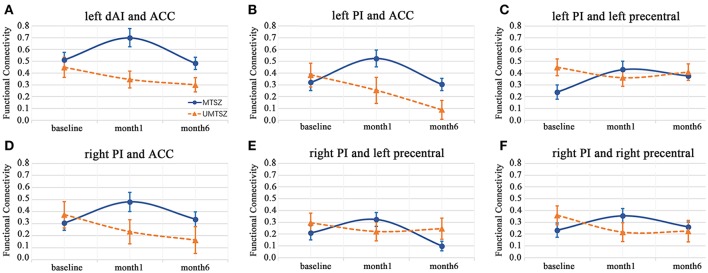
Six-month effects of music intervention versus no-music intervention on insular FC in the patients with schizophrenia. The data are expressed as the mean value ± standard error. (A) FC of left dAI and ACC; (B) FC of left PI and ACC; (C) FC of left PI and left precentral gyrus; (D) right PI and ACC; (E) right PI and left precentral gyrus; (F) right PI and right precentral gyrus.